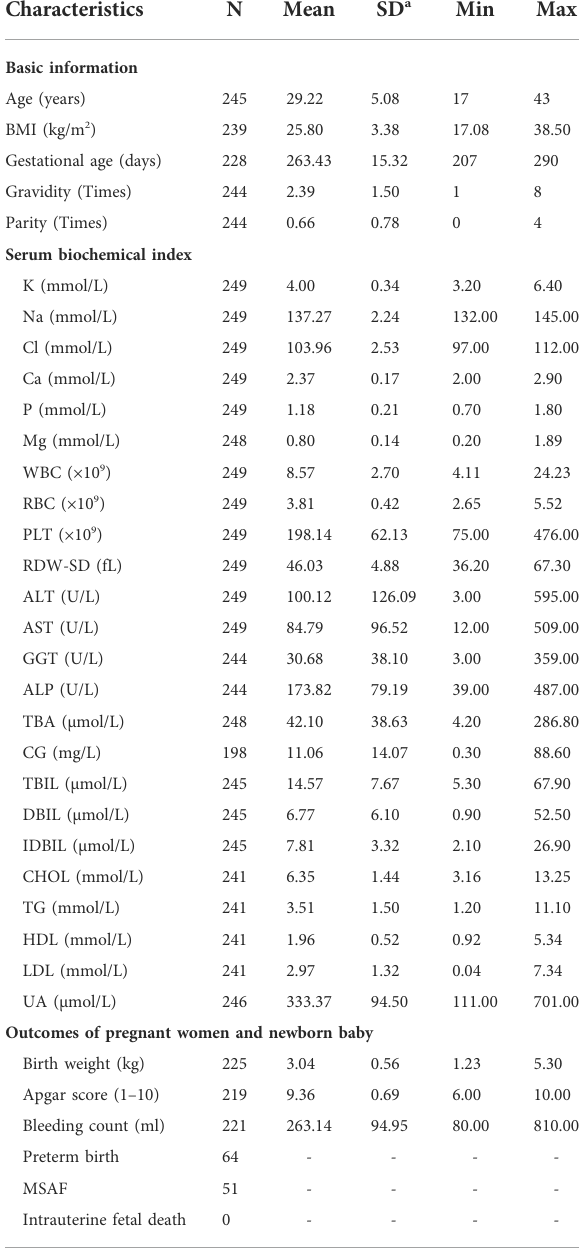
TABLE 1 Descriptive statistics of thirty- fi ve clinical characteristics of 249 ICP